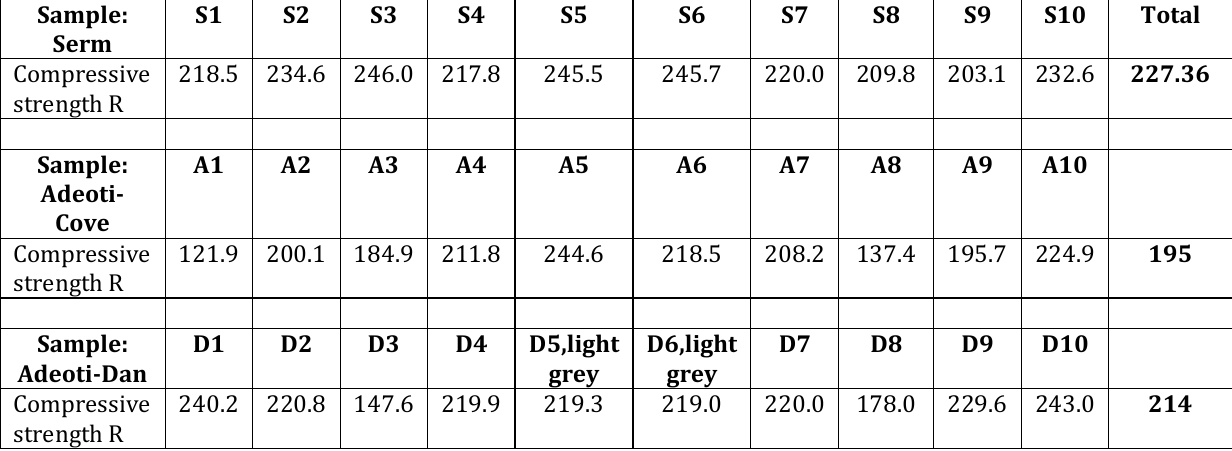
Table 5. Compressive strength